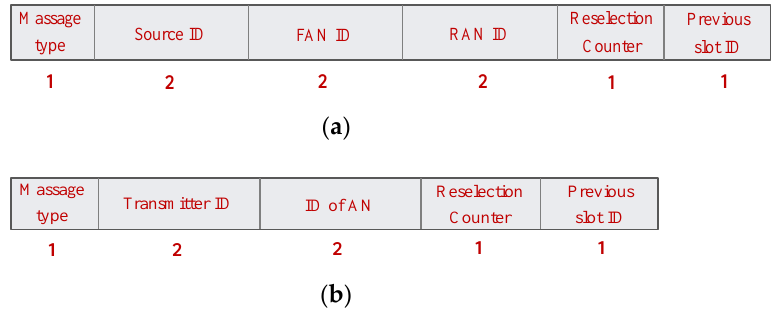
Figure 5. Format of ( a ) request-to-broadcast (RTB) and ( b ) clear-to-broadcast (CTB) messages.